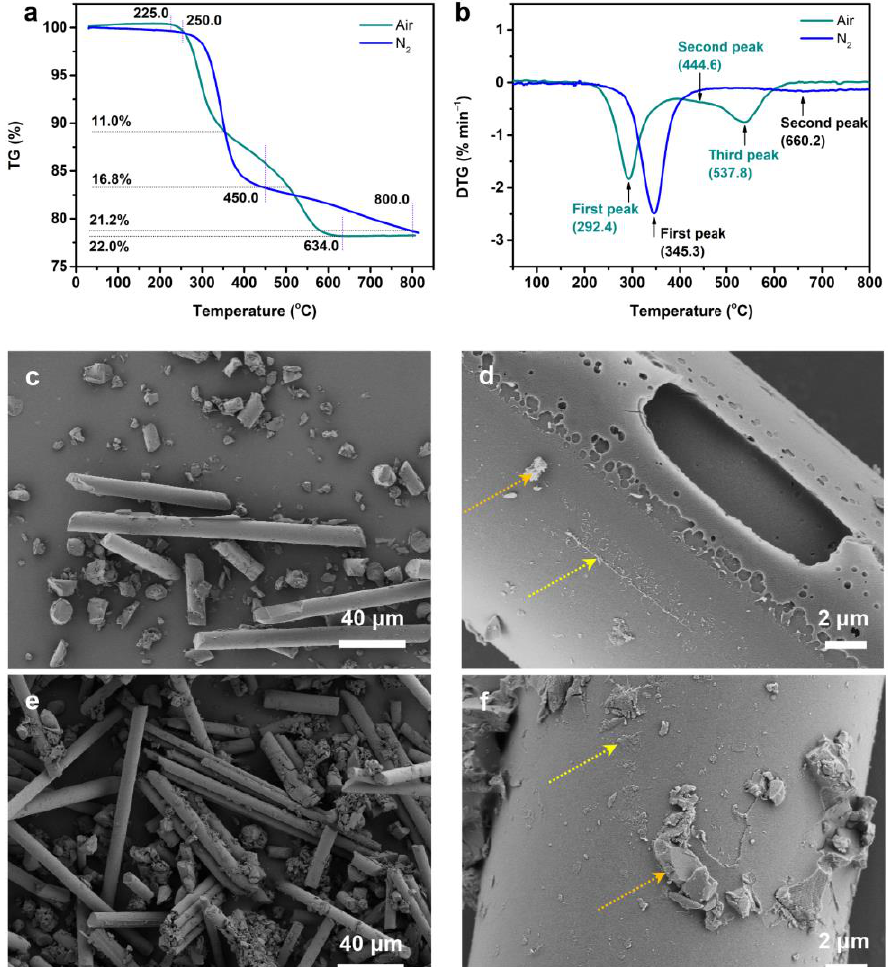
Figure 2. TG ( a ) and DTG ( b ) curves of fibers/epoxy under different atmospheres; SEM images of fibers/epoxy under different atmospheres: air ( c , d ), and N 2 ( e , f ).